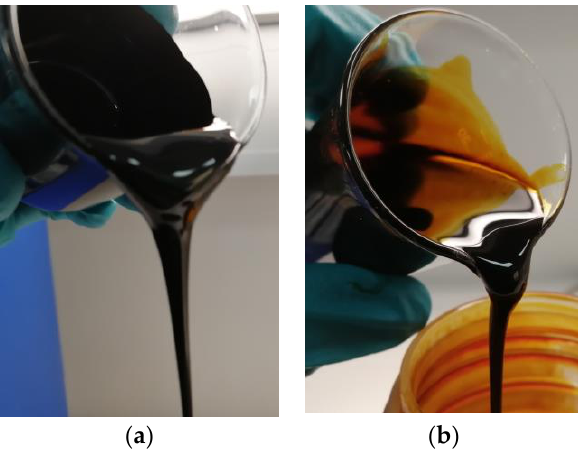
Figure 1. Example of lignocellulosic bio-oil from pinewood. ( a ) hydrothermal liquefaction (HTL); ( b ) pyrolysis.